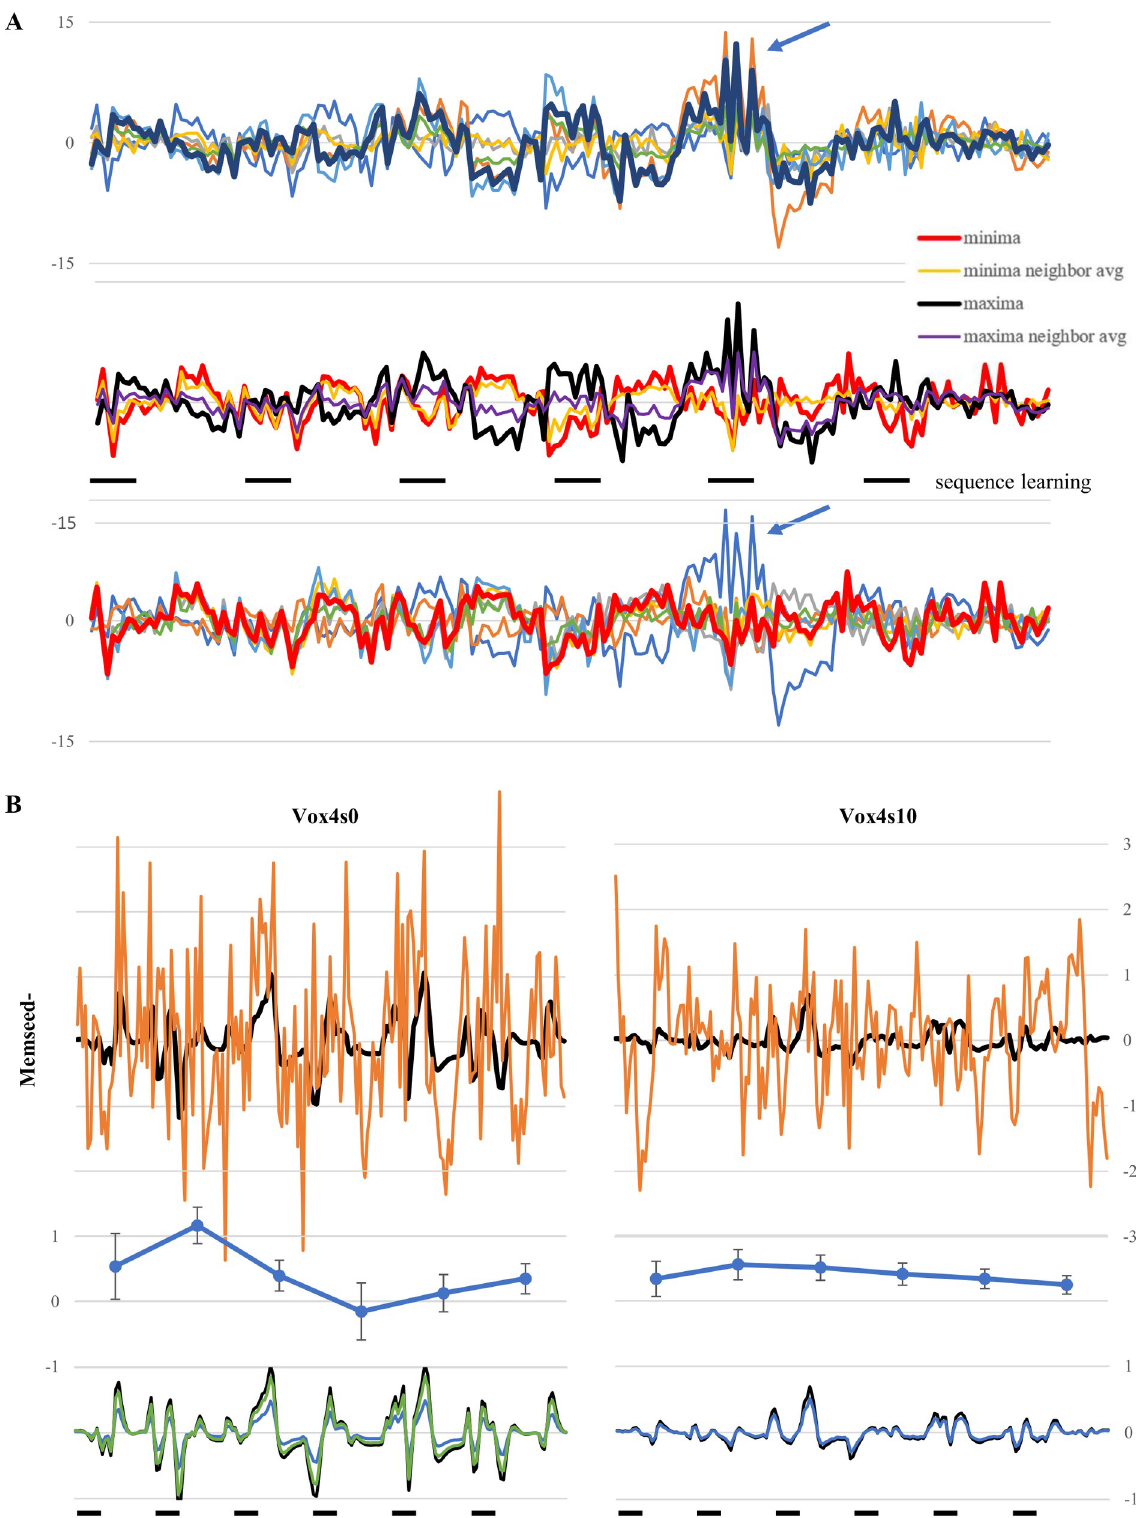
Fig 4. Temporal waveforms in the hippocampus and SMC and their role in connectivity analysis. (A) Eigenvariate waveforms for the duration of the task are shown for the activation maxima and neighboring voxels (top), the activation minima and neighboring voxels